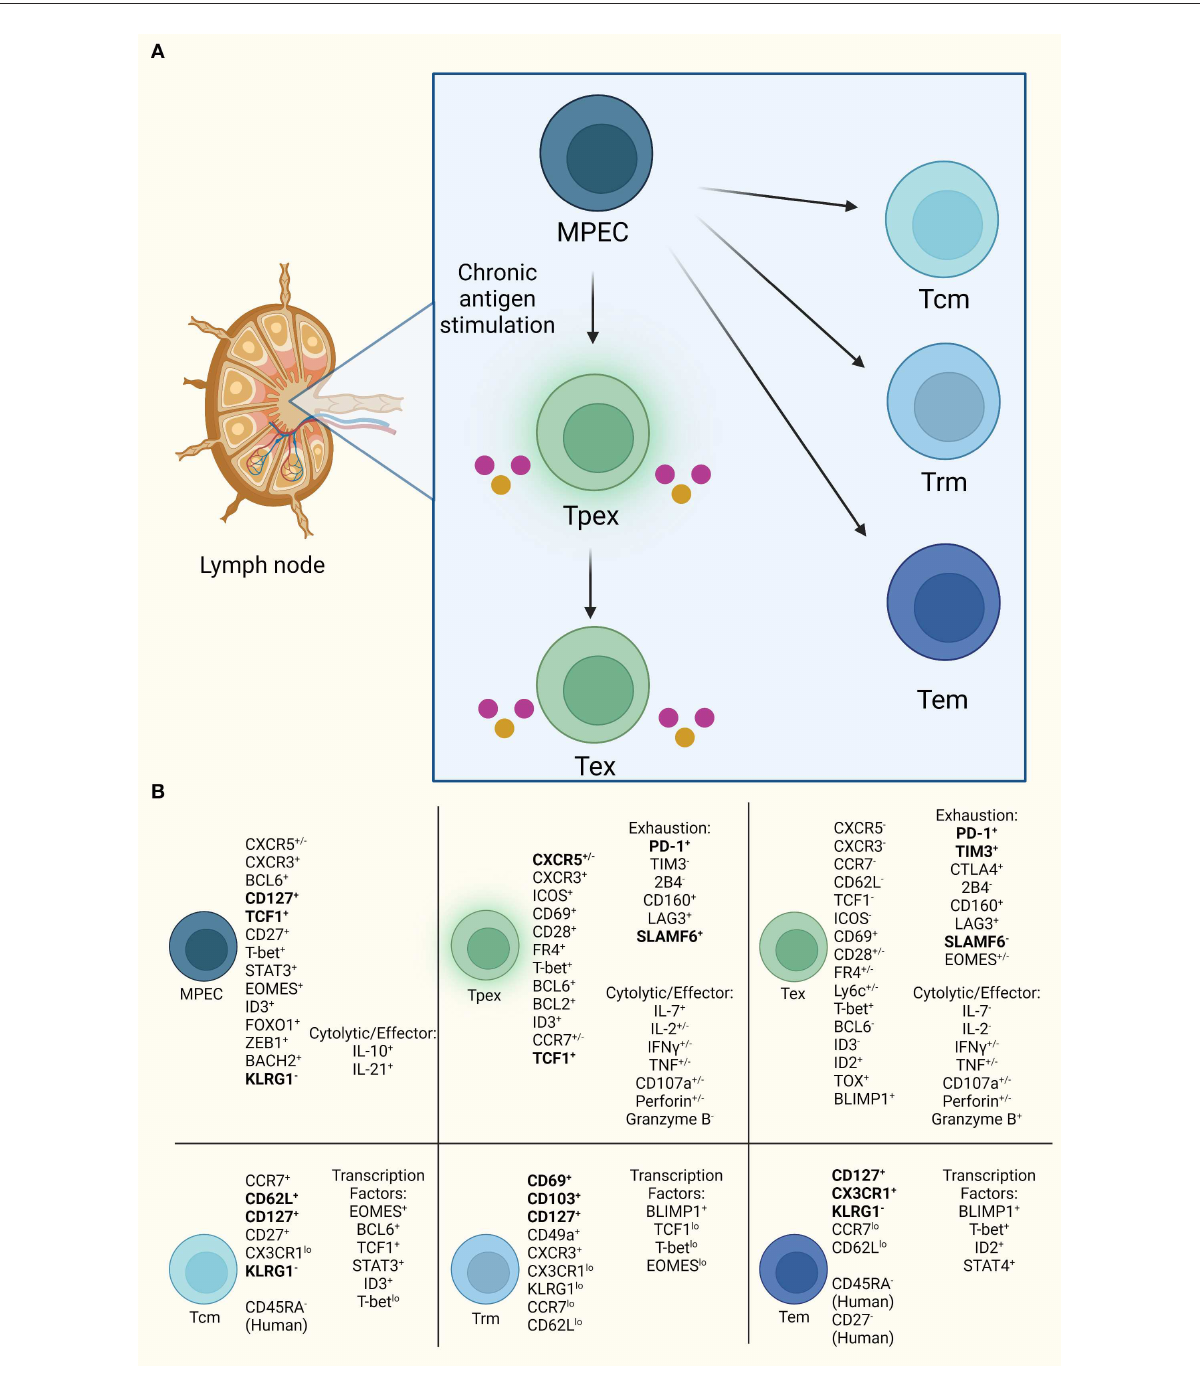
FIGURE2 CXCR5 + CD8T cell progenitor lineages. (A) CXCR5 + CD8T cells resemble progenitor cells with self-renewal, such as MPECs, that are capable of diverging into two lineages of either exhausted T cells under high antigen exposure or memory cells with effector functionality. (B) Established markers defining CD8T cells for each subset diverging from MPEC. Bold indicates consistently used markers for population identification. Also, listed are the currently demonstrated cytolytic and effector molecules in exhausted subsets.